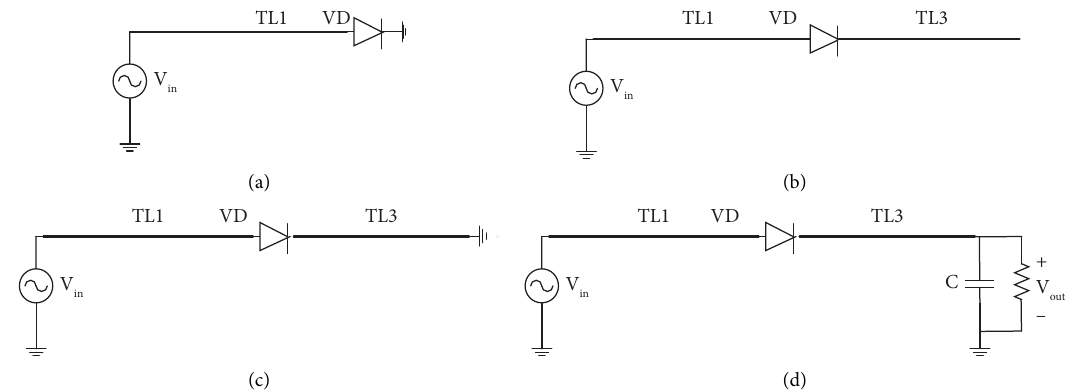
Figure 14: Decomposition circuit with SBD in series: (a) microstrip line and SBD with ground end, (b) microstrip line and SBD with open stub, (c) adding ground end on the basis of (b), and (d) rectifying circuit with SBD in series.